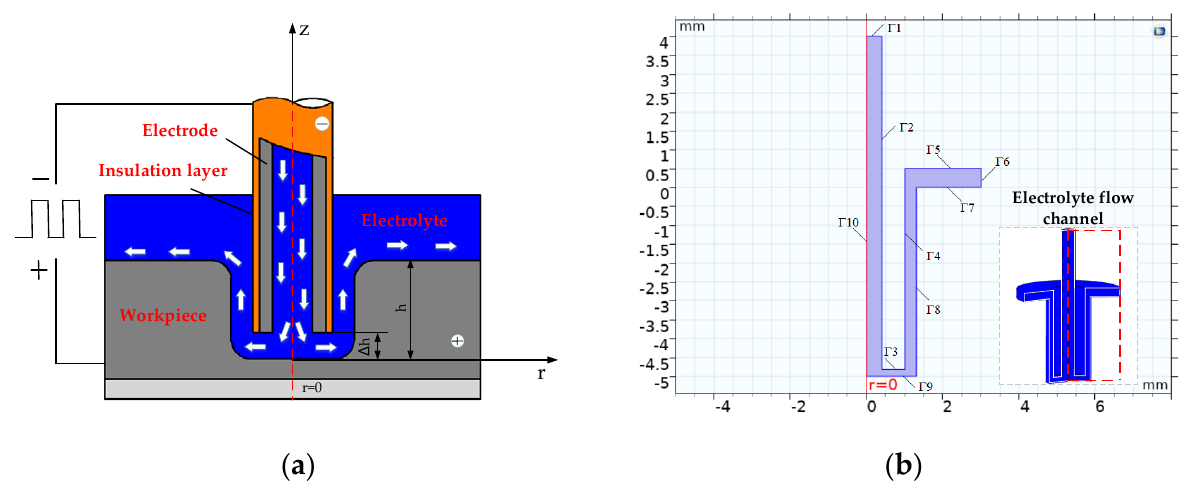
Figure 3. Geometric model of the film cooling hole machining; ( a ) schematic diagram of the machining zone; ( b ) electrolyte flow channel model and boundary definitions.